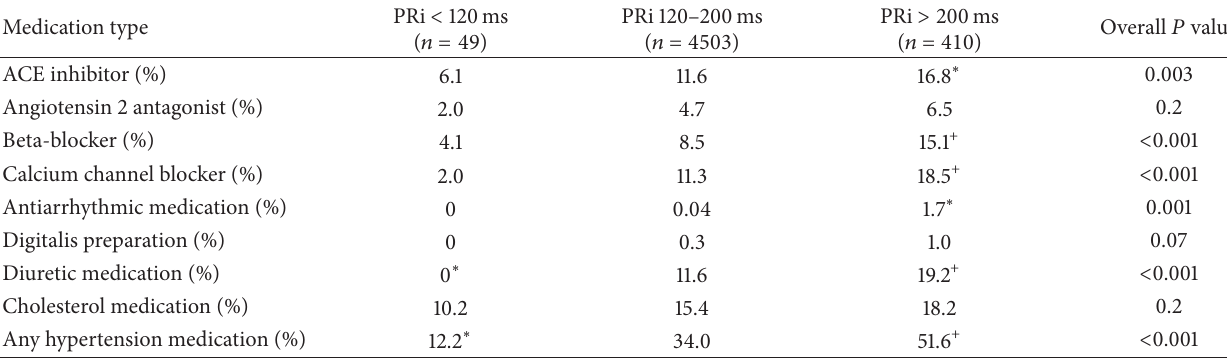
Table 2: Baseline medication use by presence of a prolonged PR interval (PRi).